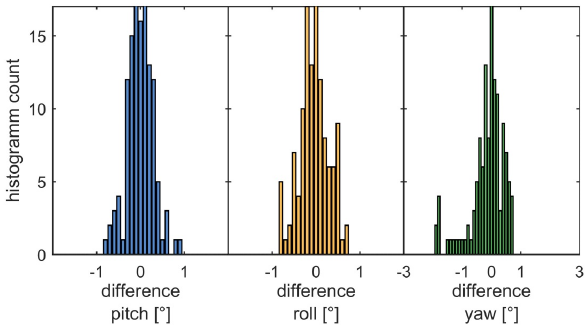
Figure 5. Histogram of differences between the indirect (SfM-computed) angles and those from the GPS/INS for Flight 1 after mounting calibration. The first images acquired during the initial state of INS are dismissed.